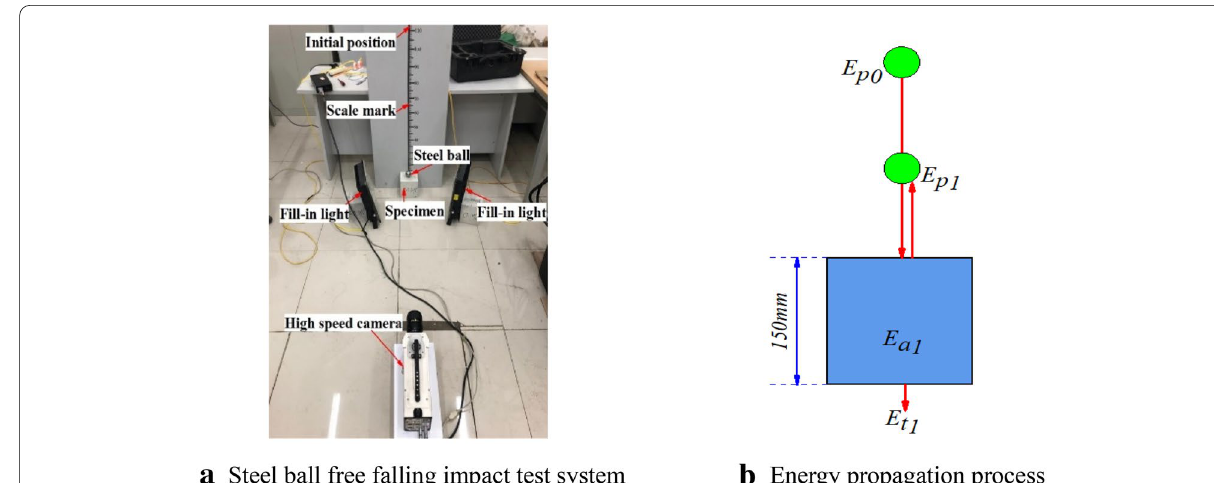
Fig. 3 Impact test instrument and energy propagation sketch.